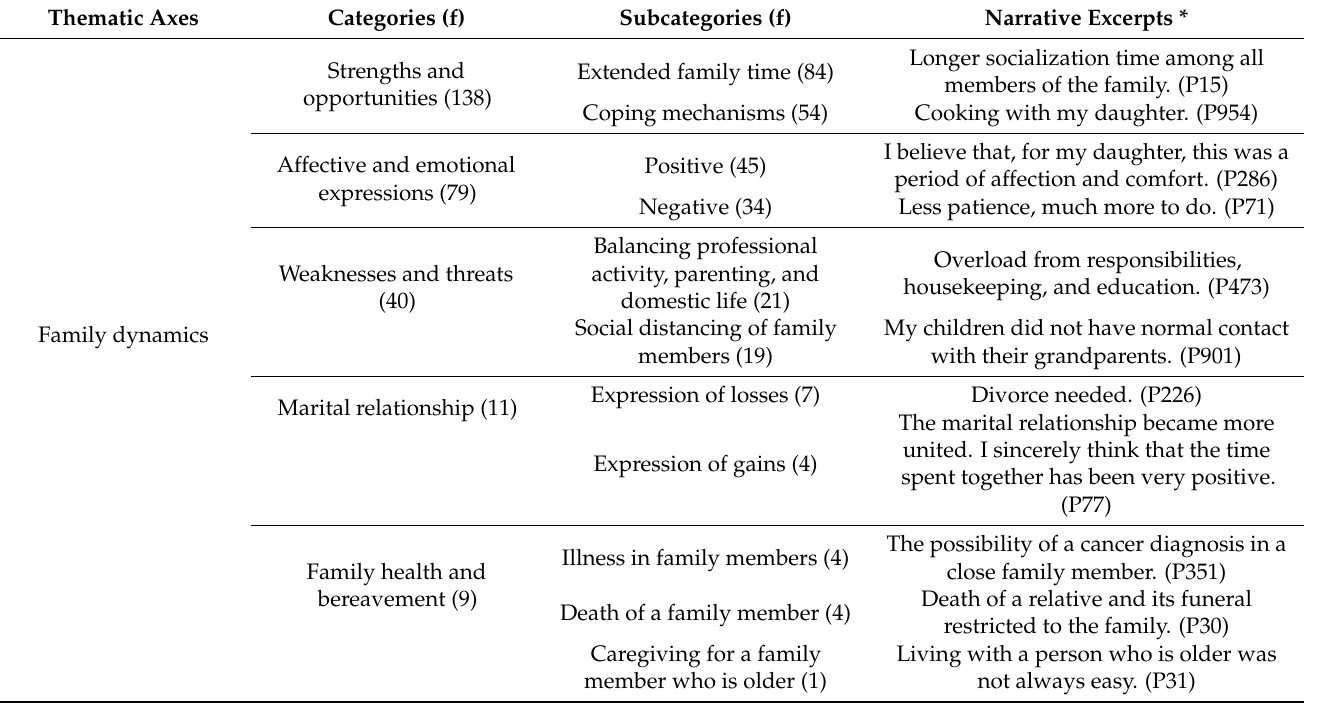
Table 6. Thematic axes, categories, and subcategories generated from the narrative